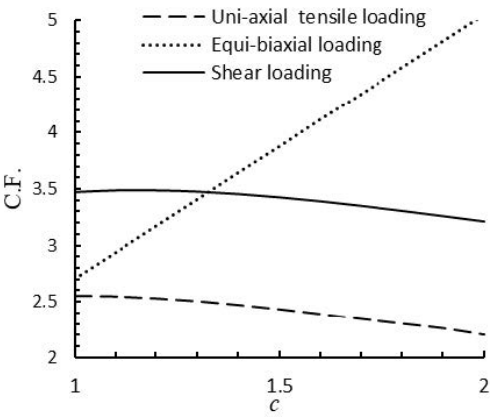
Figure 13. Variations of the C.F. in terms of c for rectangular cutout ( w =